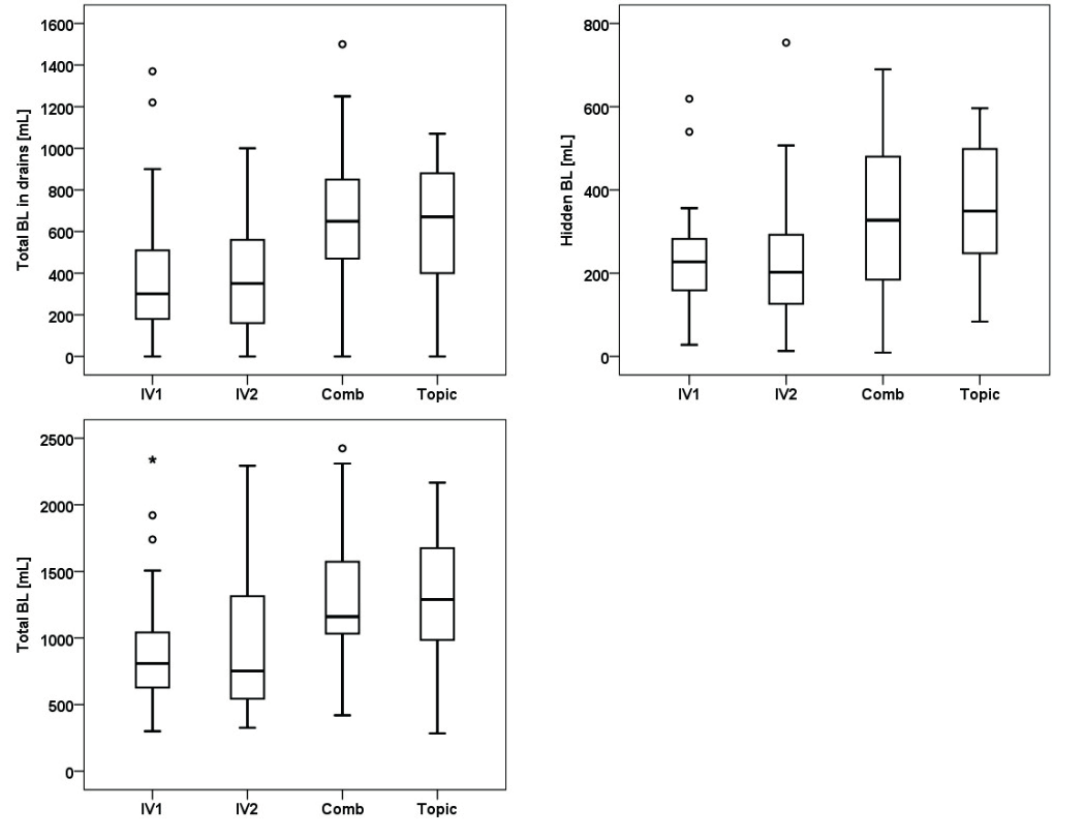
Fig. 4. Range of blood loss for each TXA